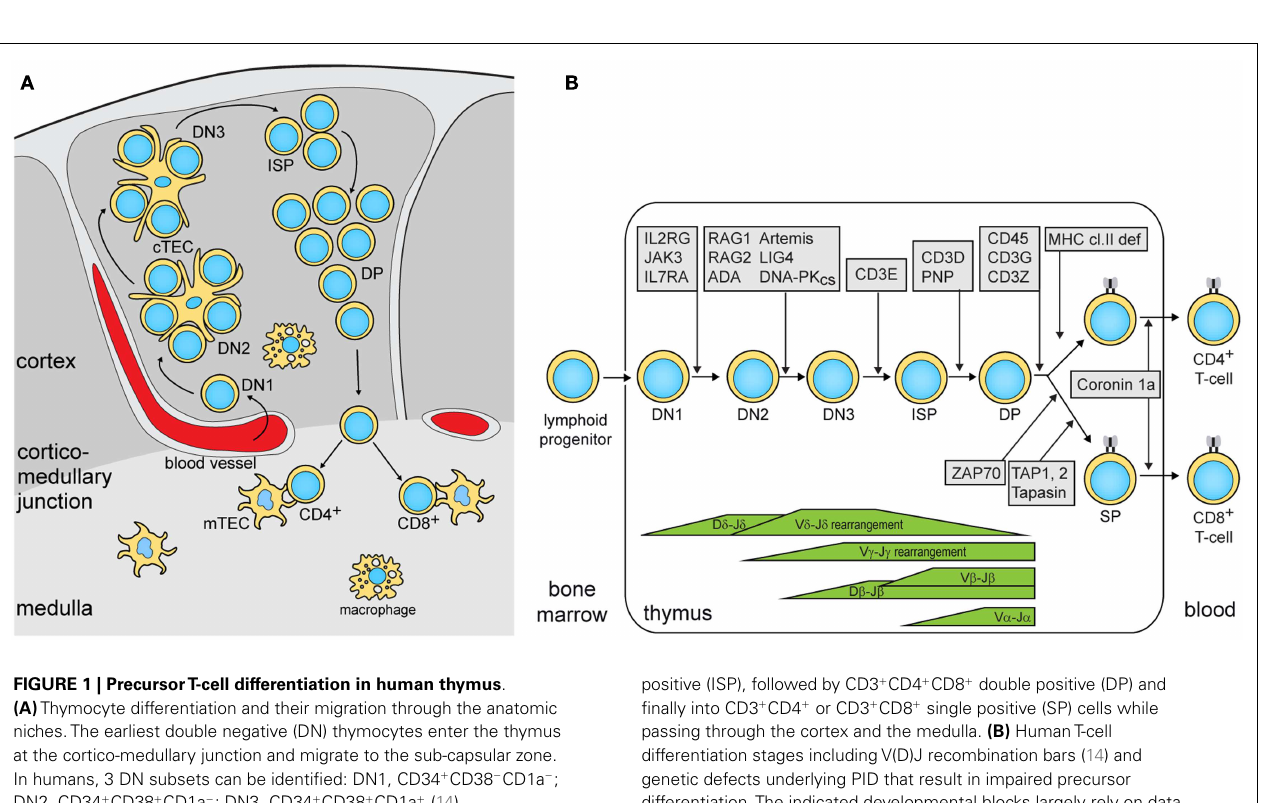
Figure. Mirjam van der Burg is sup- ported by Vidi grant 91712323 from ZonMW/NWO, and Menno C. van